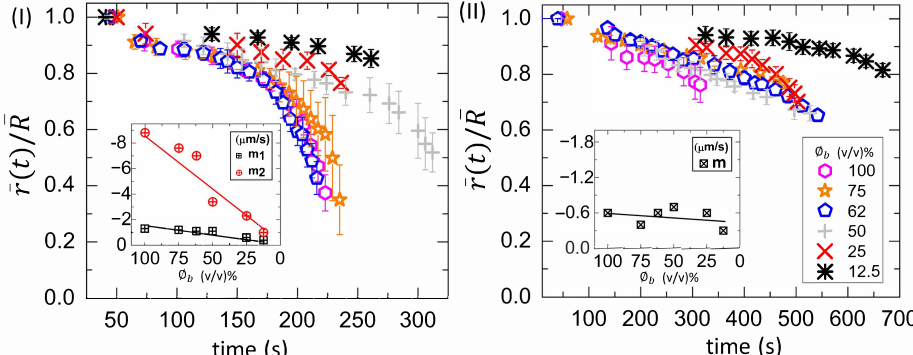
Figure 7. Time evolution of the normalized fluid front radius ( r ( t ) / R ) at different initial concentration ( φ b ) ranging from 100 to 12.5% ( v / v ) in the whole blood droplets at various substrate temperatures (T) of 45 ◦ C in ( I ) and 25 ◦ C in ( II ). The initial ( m 1 ) and final ( m 2 ) slope values are calculated from ( r ( t ) ) measurements in each region at T = 45 ◦ C, whereas the slope values ( m ) are determined from the whole range at T = 25 ◦ C. The variation of the slope with φ b is displayed in the insets of ( I ) and ( II ). The wettability of these blood droplets at T = 25 ◦ C is examined by measuring the contact angle during the drying process [Figure 8(I,II)]. The contact angle is the angle formed by the interfaces of substrate–blood, blood–air, and substrate–air [2]. It shows the drying evolution of the normalized contact angle ( θ ( t ) / Θ ) at different initial concentrations ( φ b ) ranging from 100 to 62% ( v / v ) in Figure 8(I) and from 50 to 12.5% ( v / v ) in Figure 8(II). The Θ